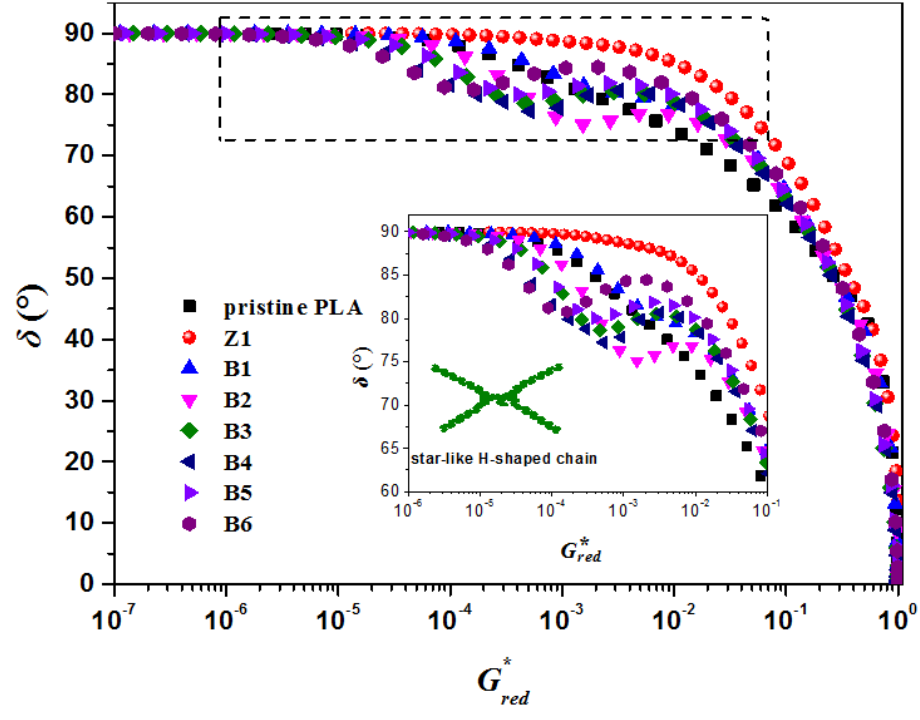
Figure 9. Reduced vGP plots for pristine PLA and modified samples at 170 ◦ Figure 3. 9 This is a figure, Schemes follow the same formatting. If there are multiple panels, they should be listed as: ( a ) Description of what is contained in the first panel. ( b ) Description of what is contained in the second panel. Figures should be placed in the main text near to the first time they are cited. A caption on a single line should be centered.